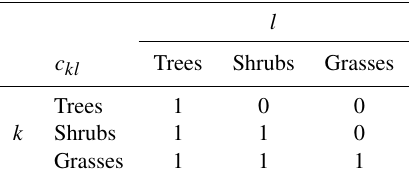
Table 2. Competition coefficients assumed for different plant func- tional groups. A more detailed example of this is given for specific PFTs in Table 3. l c kl Trees Shrubs Grasses